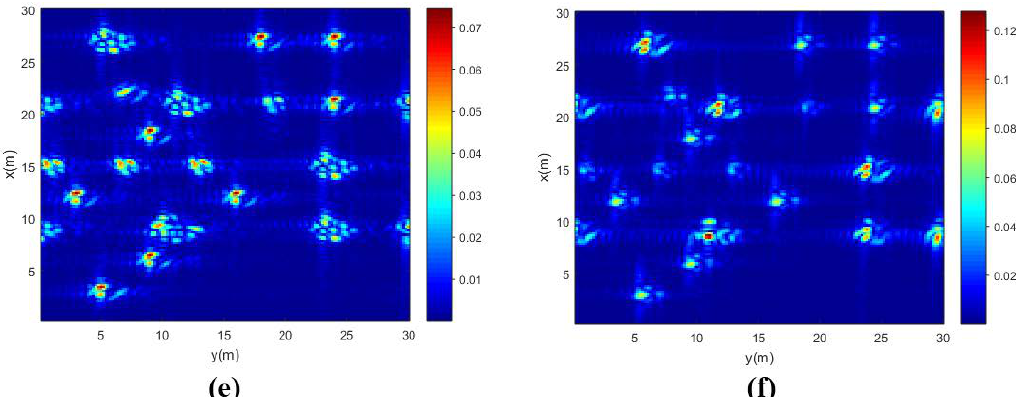
Figure 6. UAV imaging results of trees at different receiver zenith angles: ( a ) receiving zenith angle = 26 ◦ ; ( b ) receiving zenith angle = 36 ◦ ; ( c ) receiving zenith angle = 46 ◦ ; ( d ) receiving zenith angle = 56 ◦ ; ( e ) receiving zenith angle = 66 ◦ ; ( f ) receiving zenith angle = 76 ◦ .